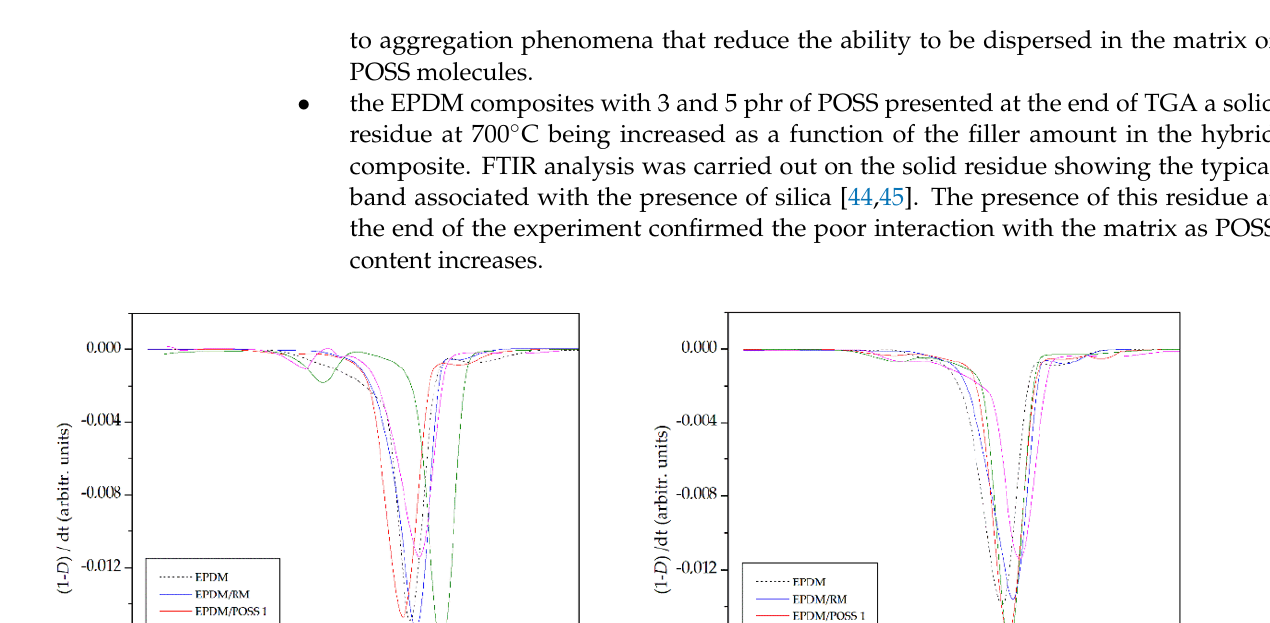
Figure 3. Thermogravimetric curves for the EPDM formulations. ( a ) unirradiated samples; ( b ) the samples subjected to a γ -dose of 50 kGy.